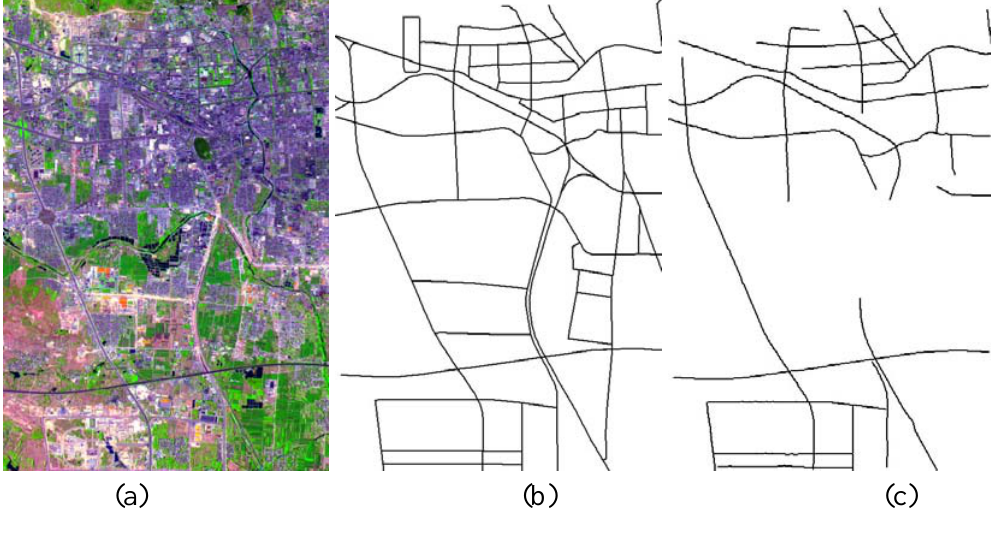
Figure 3. Road network extraction from a SPOT5 satellite image. (a) SPOT5 fused image with 2.5 m pixel -1 resolution and an image size of 3,750 pixels by 2,499 pixels; (b) the reference road network plotted; (c) the extracted vector road network by the combination